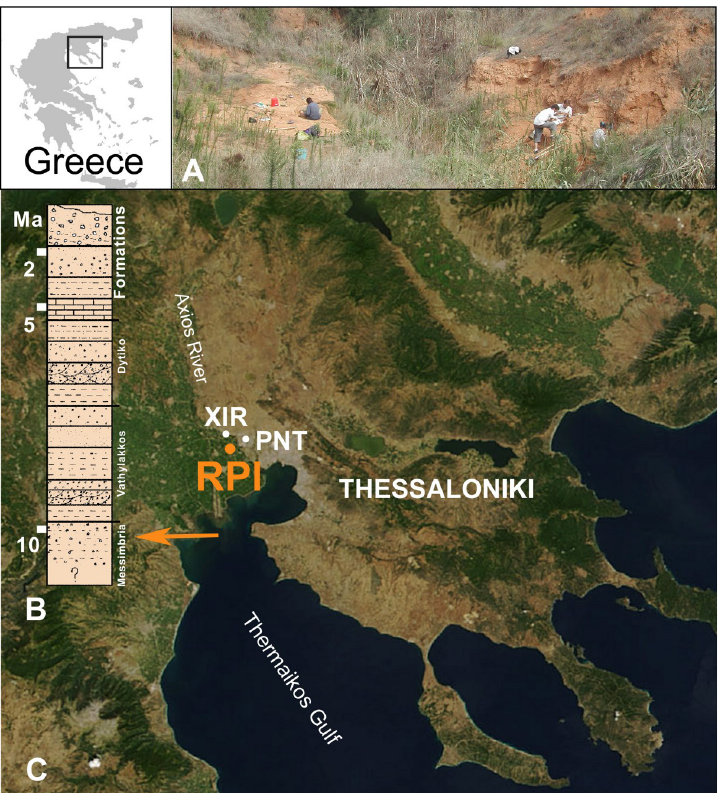
Fig 2. The late Miocene site of Ravin de la Pluie, RPI (Thessaloniki Macedonia, northern Greece). View of the dig (A) and its location of the stratigraphy modified after [19] (B) and in the Axios Valley (C), near the two other richest Vallesian vertebrate localities. XIR: Xirochori and PNT: Pentalophos. Source of the satellite image: NASA Earth